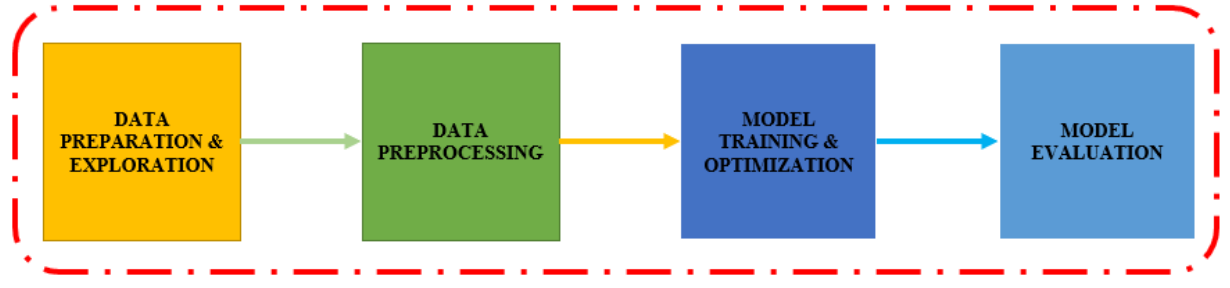
Figure 4. Model development workflow.